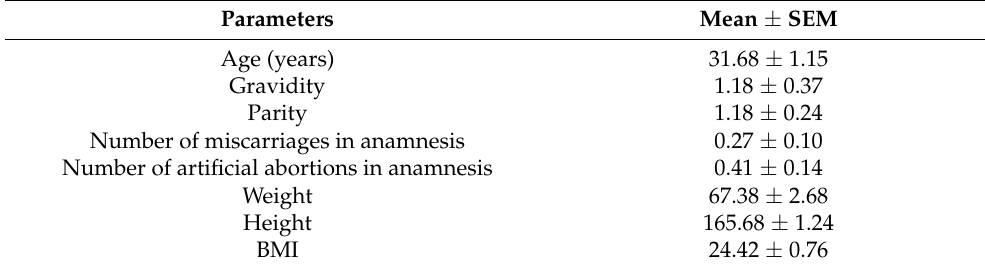
Table 1. Clinical characteristics of patients enrolled in the study ( n =